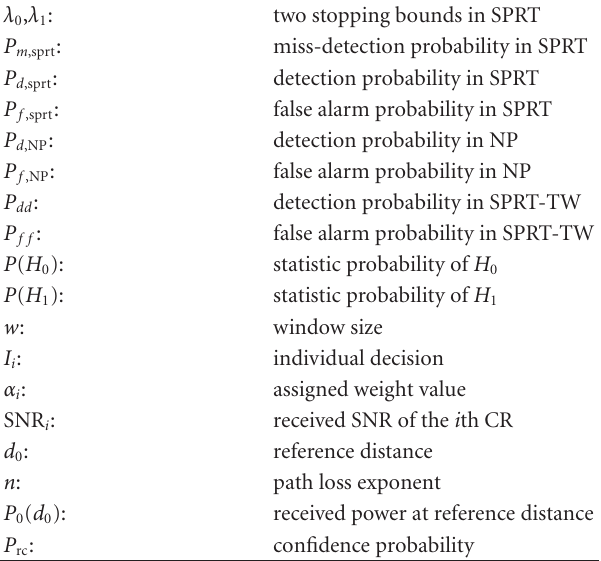
Table 1: Notation